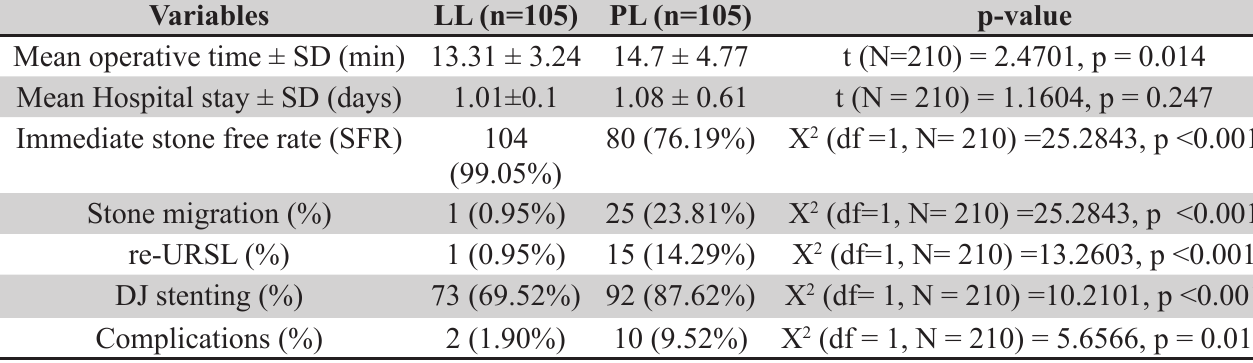
Table 2. Comparison of operative and post-operative parameters